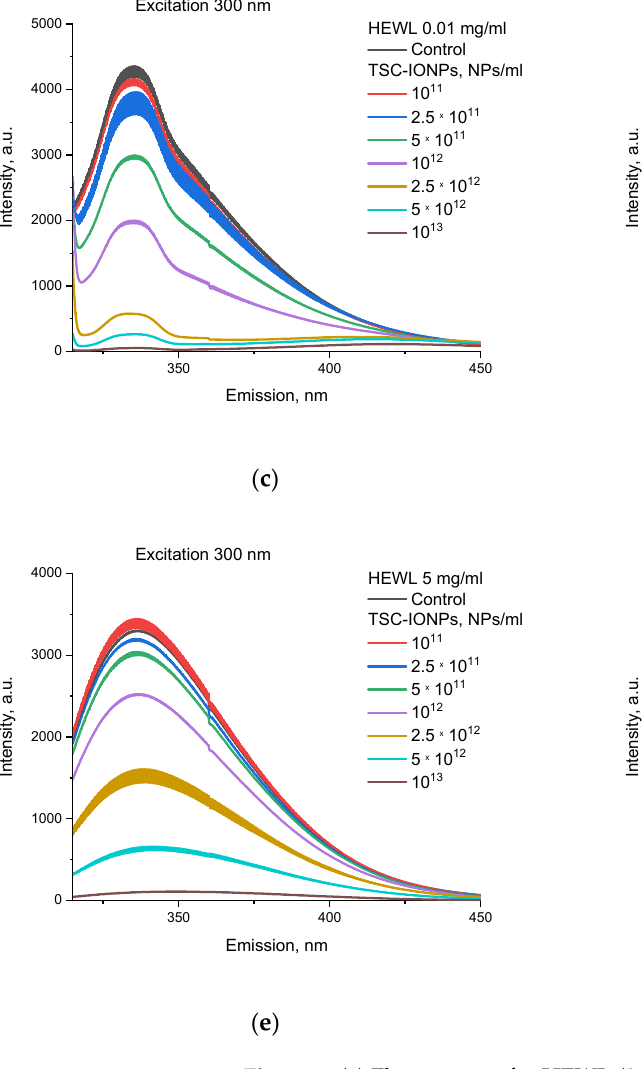
Figure 5. ( a ) Fluorescence for HEWL (0.4 and 5 mg/mL), HEWL with TSC (1 M), and HEWL with TSC-IONPs (10 13 NPs/mL). The points show the positions of the maxima. The intensities and coordinates of the maxima are written at the top of the graph. ( b ) Normalized emission of HEWL samples of various concentrations upon the addition of TSC-IONPs. ( c – f ) Emission of 0.01, 0.4, 5, and 100 mg/mL HEWL samples with different concentrations upon the addition of TSC-IONPs. Results are presented as mean and SD for three independent experiments. Table 1. Fluorescence peak position (mean and standard deviation) when excited on 300 HEWL samples at 0.01, 0.4, 5, and 100 mg/mL. See Figure 5. HEWL